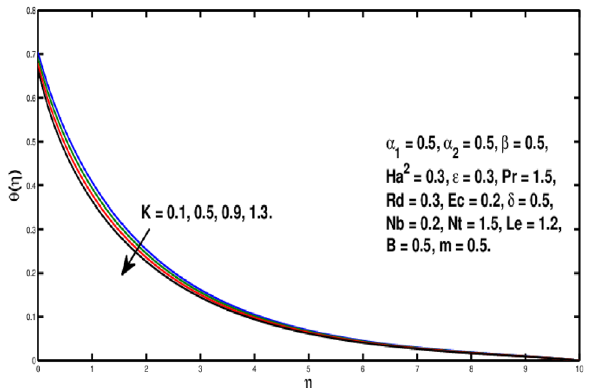
Figure 8. Variation of K on θ(η) .